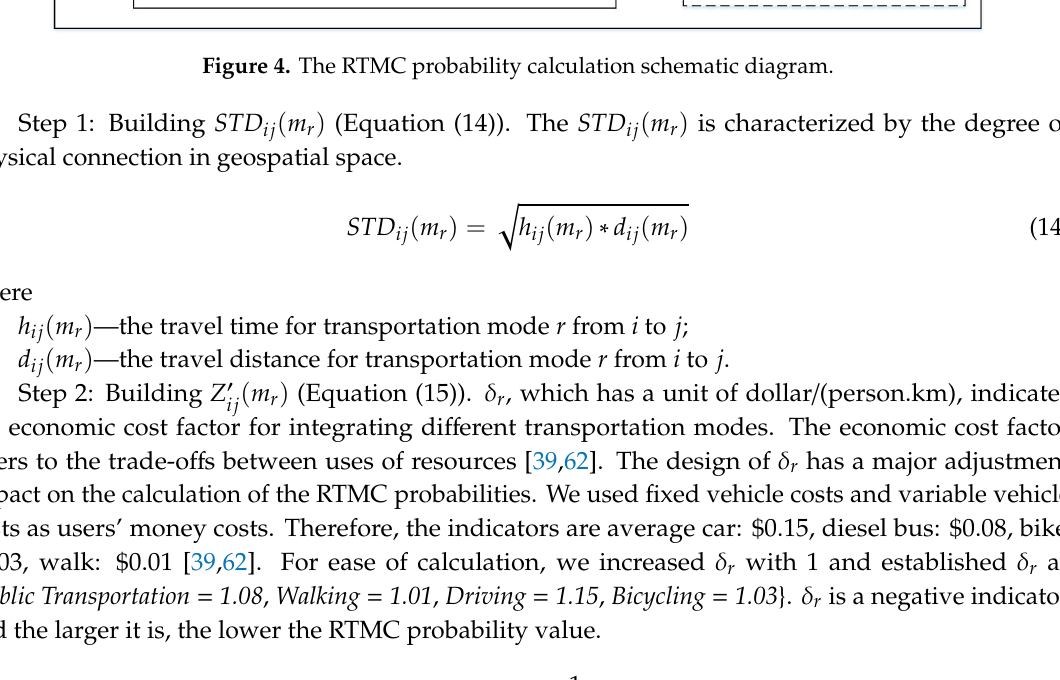
Figure 4. The RTMC probability calculation schematic diagram.